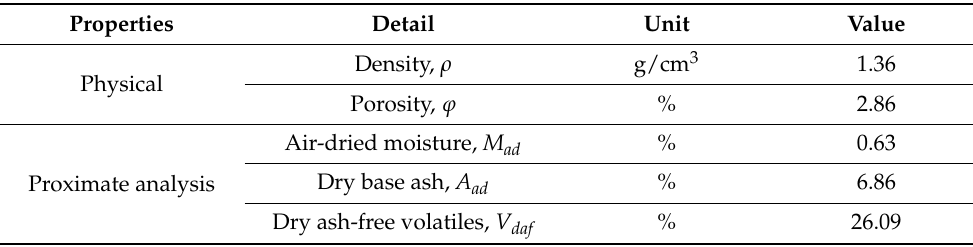
Table 1. Basic properties of Malan